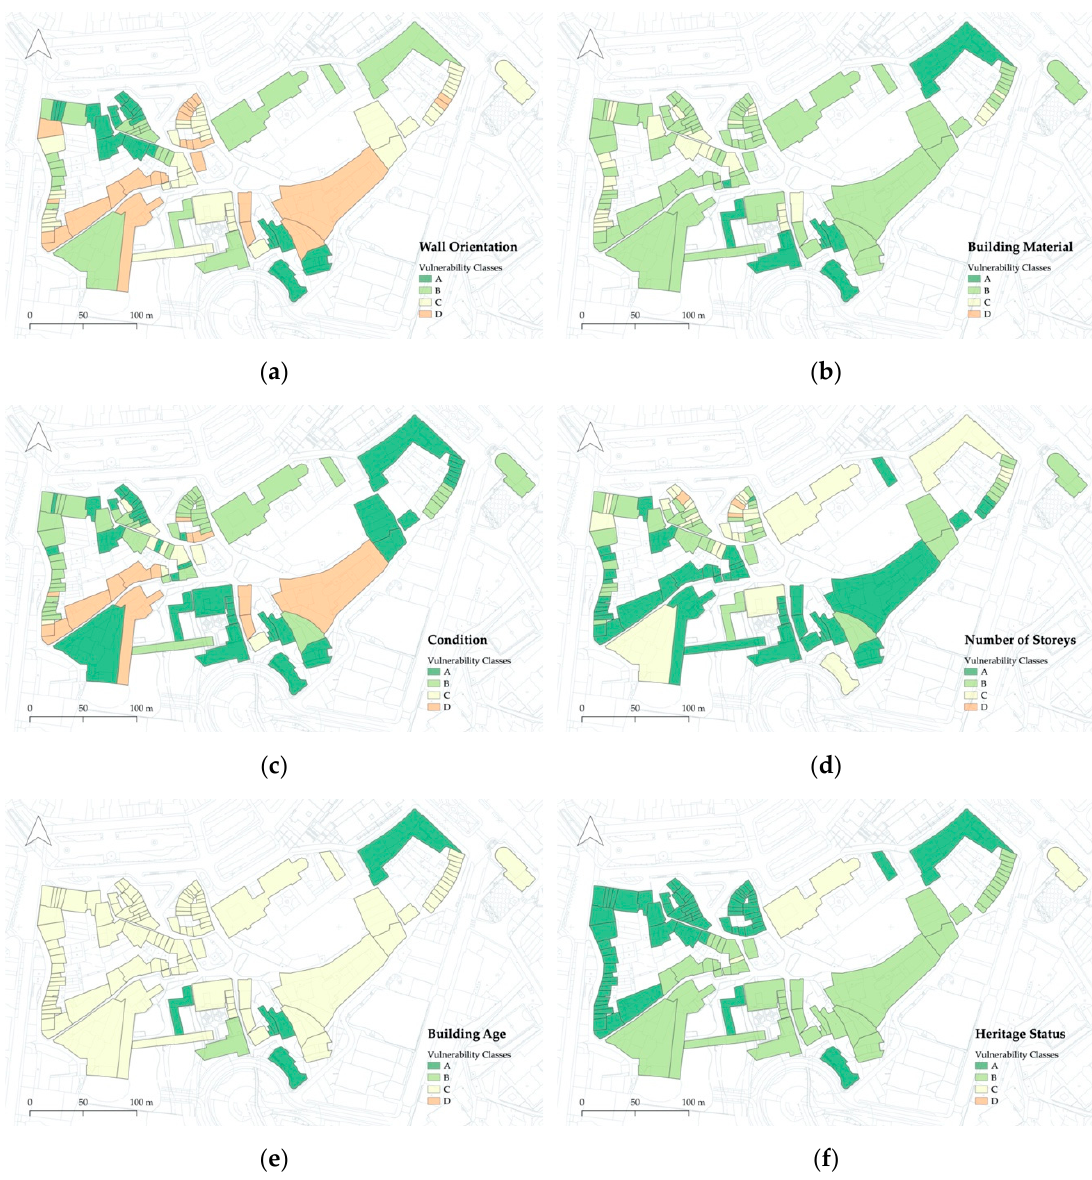
Figure 7. Mapping of the spatial distribution of the vulnerability classes: ( a ) Wall Orientation; ( b ) Building Material; ( c ) Condition (or conservation status); ( d ) Number of Storeys; ( e ) Building Age; ( f ) Heritage Status.